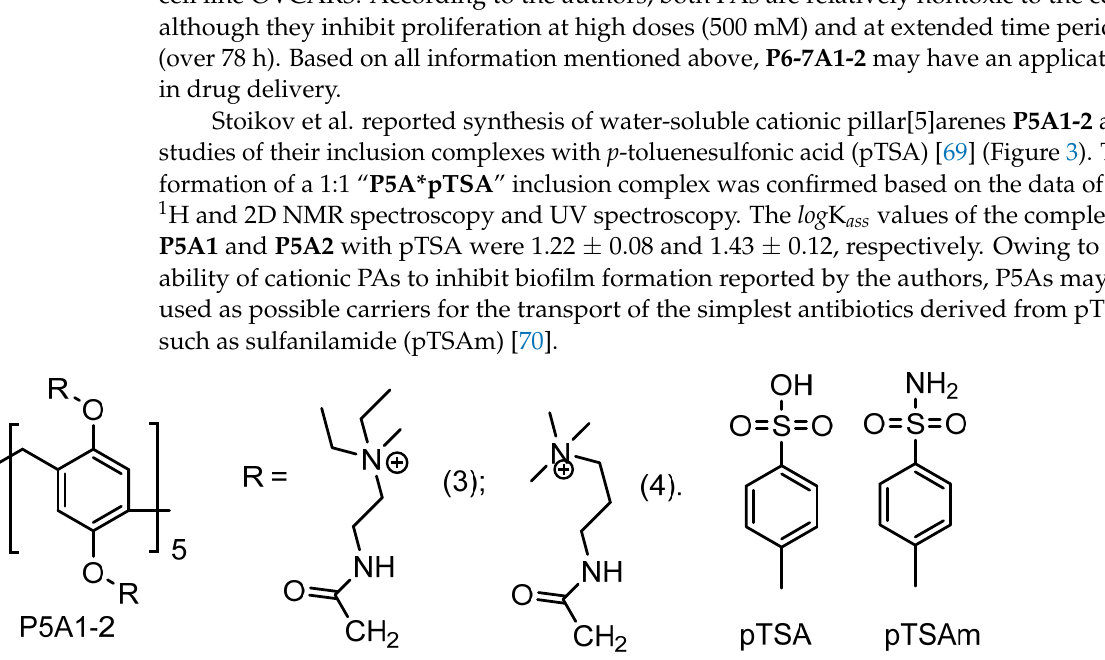
Figure 3. P5A1-2 as hosts for pTSA and, possibly, for pTSAm.